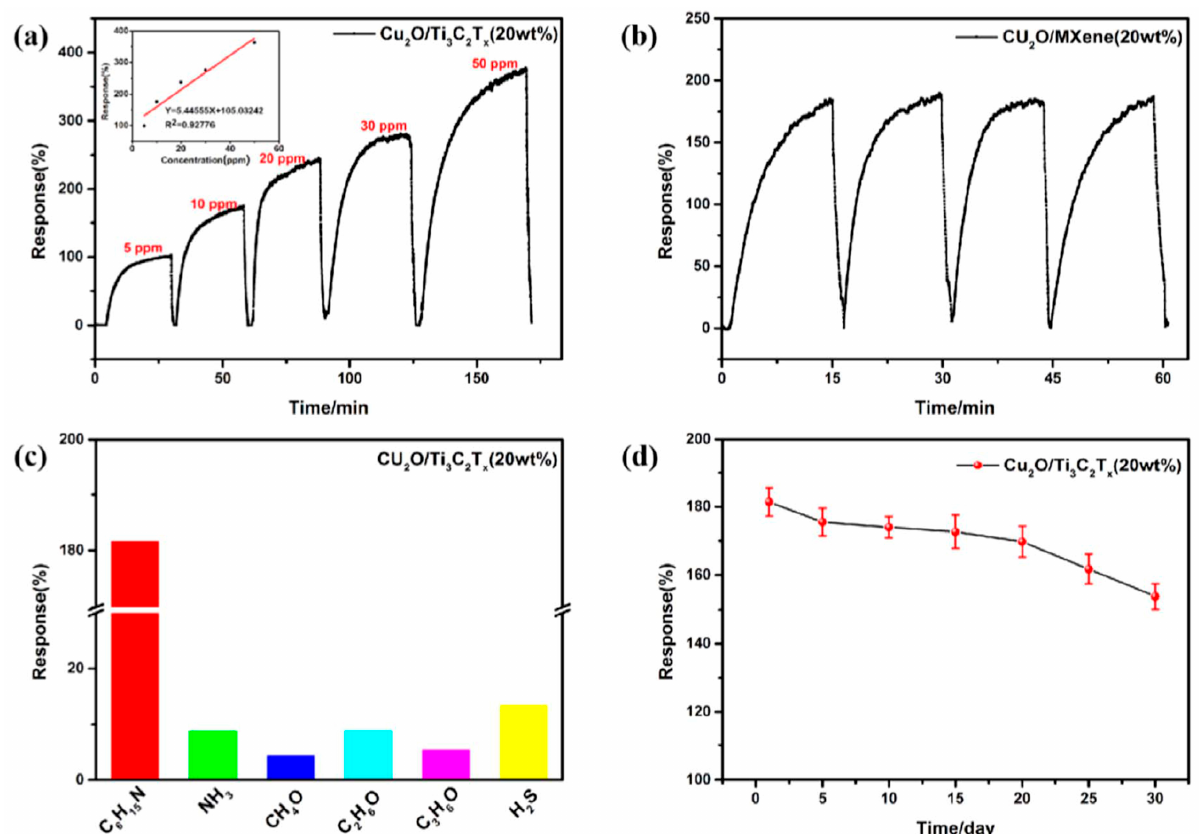
Figure 31. ( a ) Dynamic response/recovery curve of the Cu 2 O/Ti 3 C 2 T x (20 wt.%) gas sensor to different concentrations of TEA gas, ( b ) Reproducibility of Cu 2 O/Ti 3 C 2 T x (20 wt.%) gas sensor on successive exposures (four cycles) to 10 ppm TEA at RT, ( c ) Selectivity to 10 ppm different gases of the Cu 2 O/Ti 3 C 2 T x (20 wt.%)-based gas sensor at RT, ( d ) long-term stability of the Cu 2 O/Ti 3 C 2 T x (20 w.t%)-based gas sensor. Reprinted with permission from [143]. Copyright 2022: IOP Publishing Ltd.